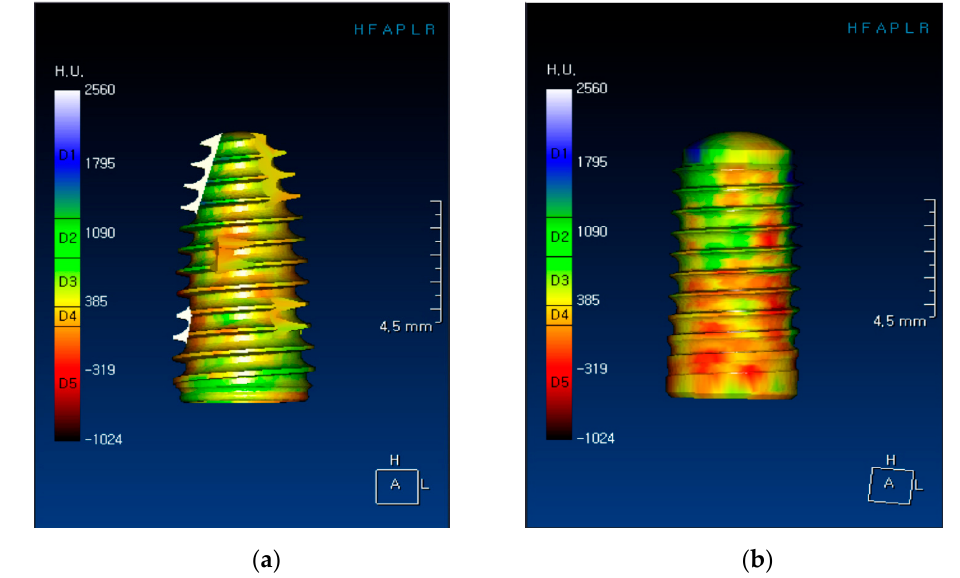
Figure 1. Three-dimensional images of implants showing bone types and corresponding Hounsfield units, generated by OnDemand ® software (Cybermed, Seoul, Korea): ( a ) CMI implant and ( b ) SLActive implant. Table 1. Mean Hounsfield units, maximum insertion torque, and implant stability quotient values and corresponding correlations with sex, age, and types of implants and